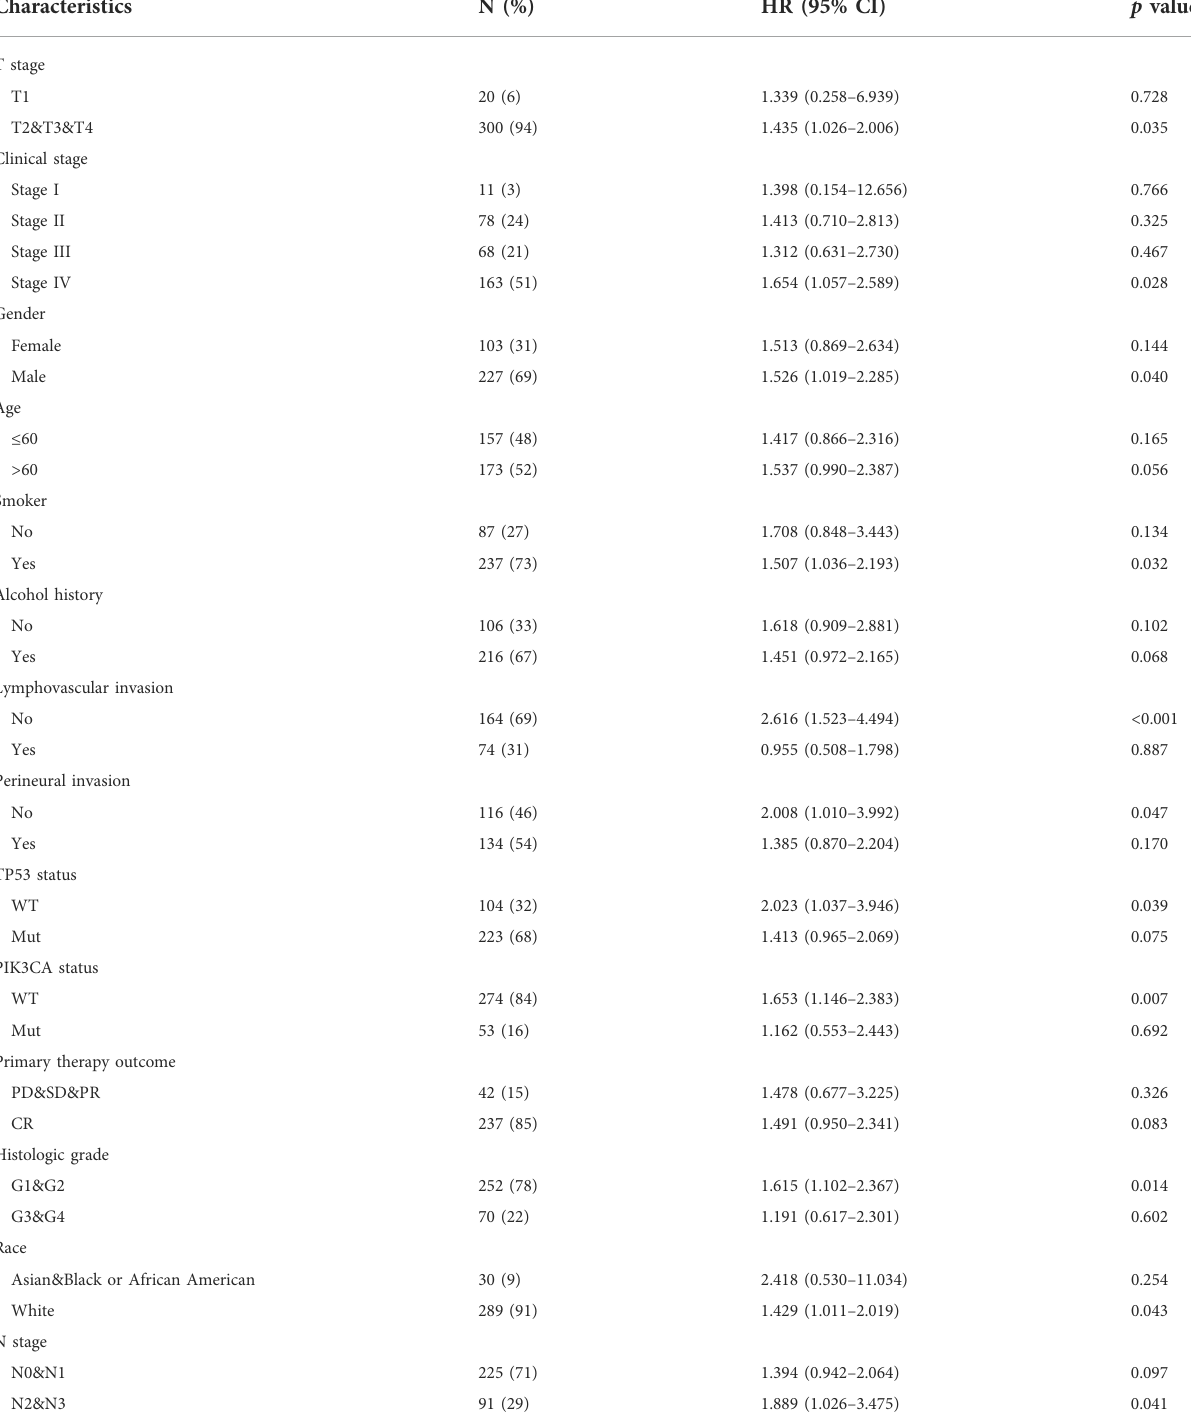
TABLE 4 Overall survival prognostic performance of DDX59-AS1 on clinical outcomes in OSCC patient subgroups by Cox regression analysis.